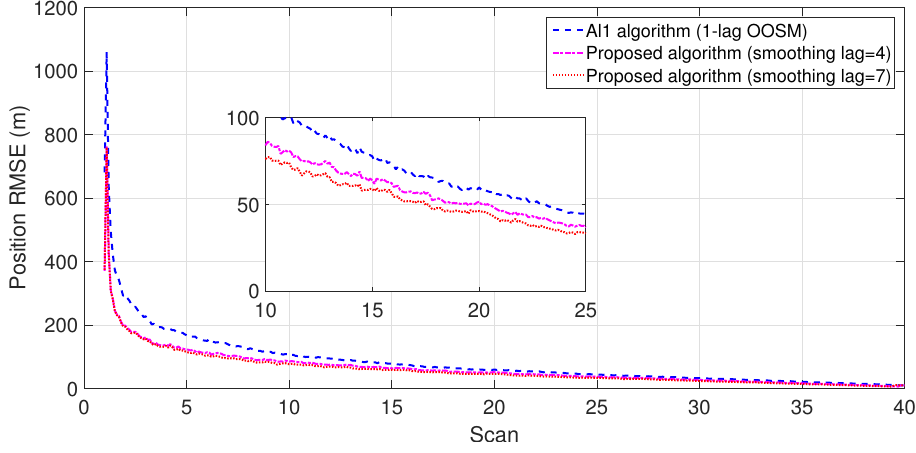
Al1 algorithm (1-lag OOSM) Proposed algorithm (smoothing lag=4) Proposed algorithm (smoothing lag=7)